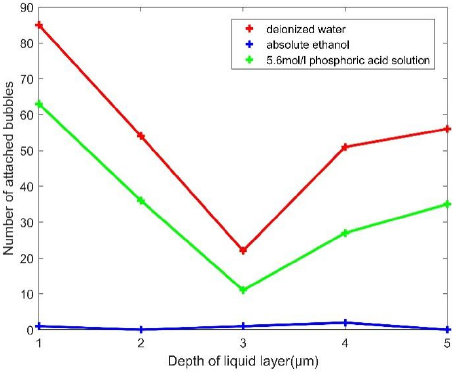
Figure 3. The number of attached bubbles under different liquid mediums and depths of liquid layer at the end of 2-second machining.